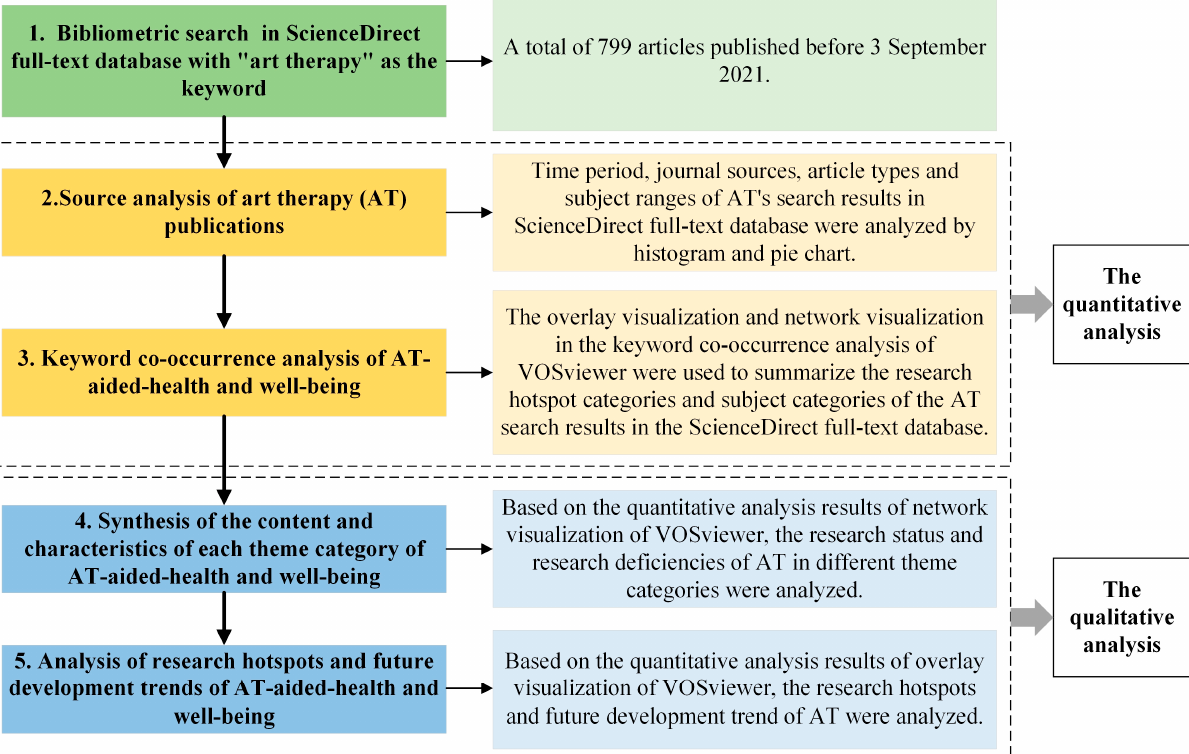
Figure 1. The flow chart of the research methodology.